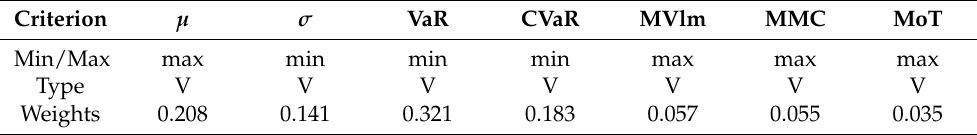
Table 3. Heading of decision